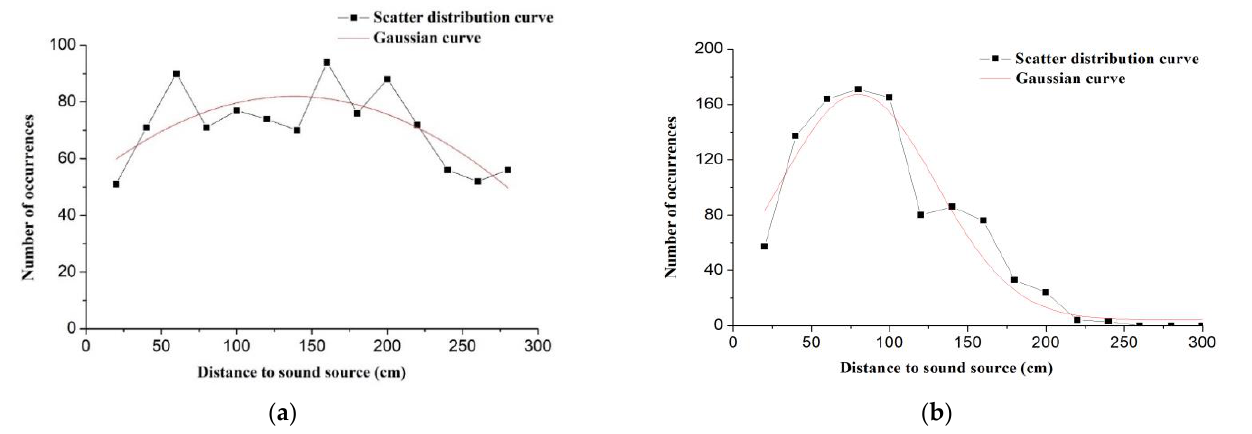
Figure 6. Spatial distribution frequency of juvenile Pagrus major in the control tank ( a ) and test tank ( b ) after eight days of training with 400 Hz square-wave continuous tones.